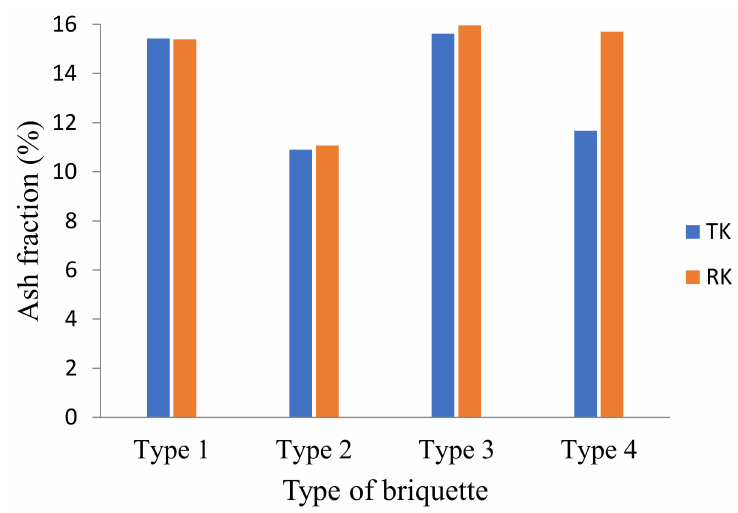
Figure 4. Ash fraction in the rotary kiln (RK) and the tubular kiln